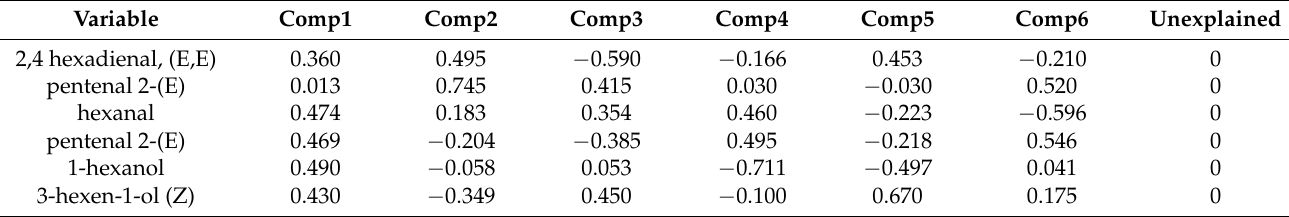
Table 12. Component loadings of the volatile compounds of EVOOs.